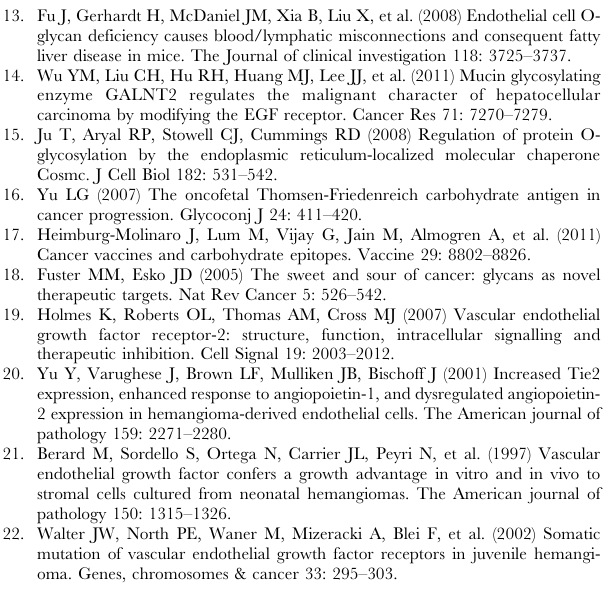
Figure S2 Immunohistochemistry of VVA in proliferat- ing hemangioma and liver. The proliferating infantile hemangioma, which is the same as in Fig. 1A, and human liver tissue with or without neuraminidase treatment were stained with VVA. Scale bar, 50 m m. Figure S3 Effects of COSMC on cell proliferation. (A) COSMC overexpression increased cell proliferation of HUVEC cells. Cell proliferation was analyzed by MTT assays. (B) COSMC knockdown inhibited cell proliferation. Results are presented as means 6 SD from three independent experiments. * P , 0.05 and ** P , 0.01, compared with control.